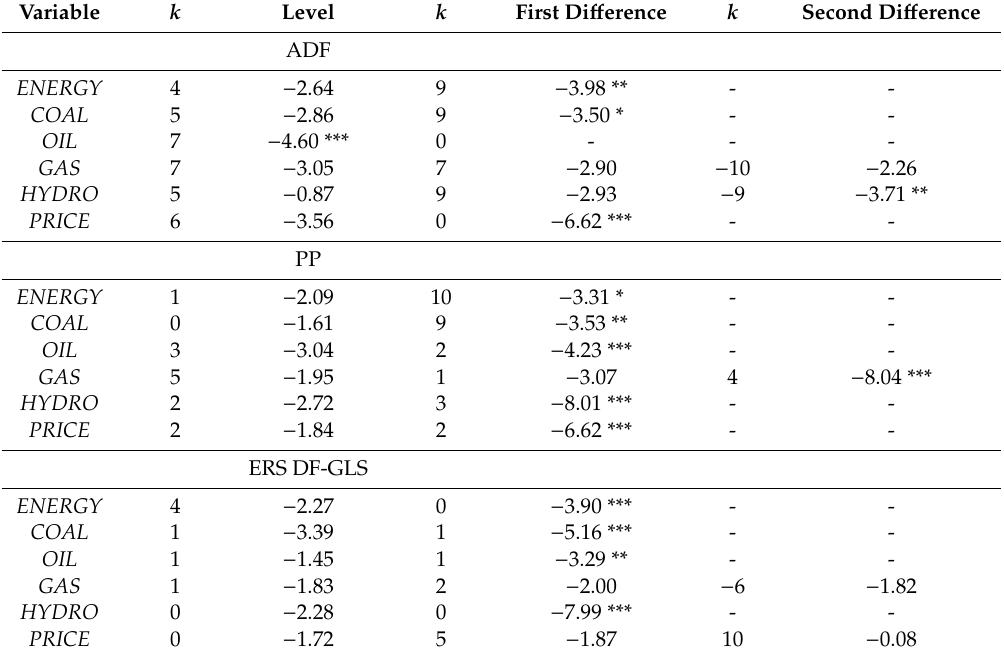
Table 3. Unit root